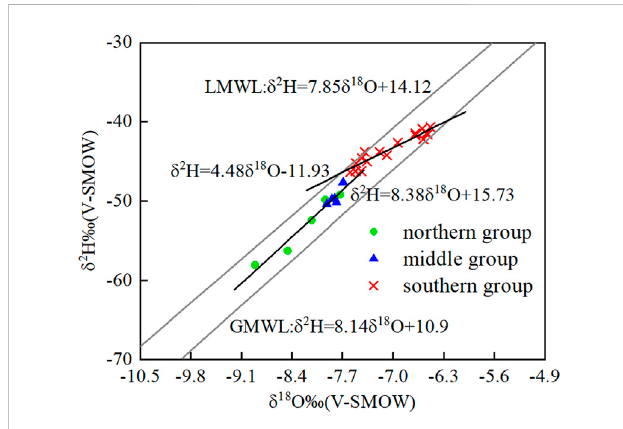
FIGURE 5 Isotopes δ 2 H and δ 18 O binary graph.